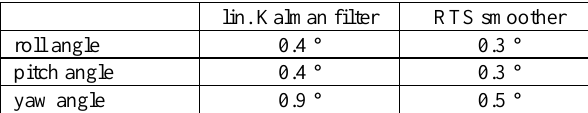
Table 1. 1-σ-Accuracy of the Attitude Reference